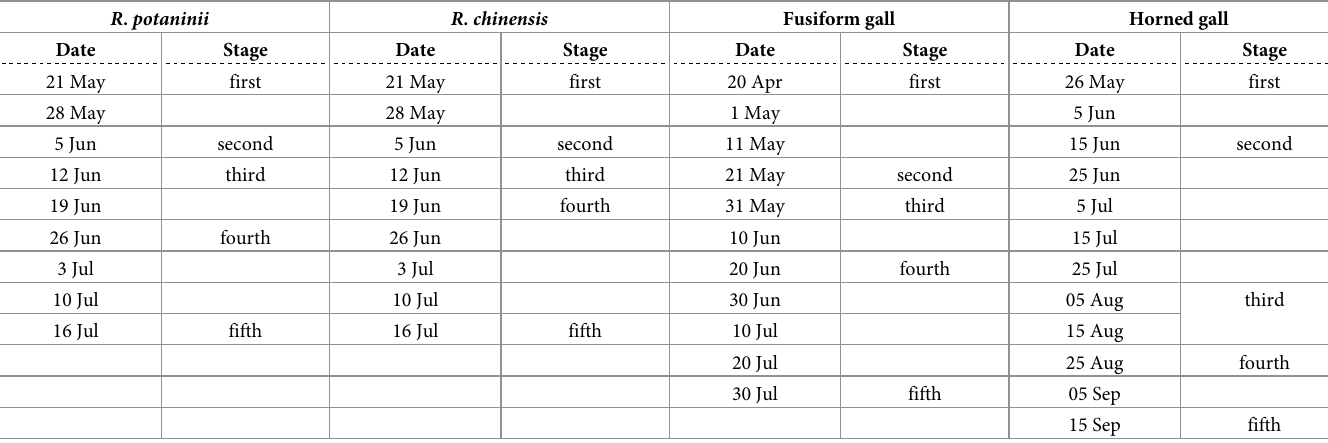
Table 1. Sample collection date and definitions of developmental